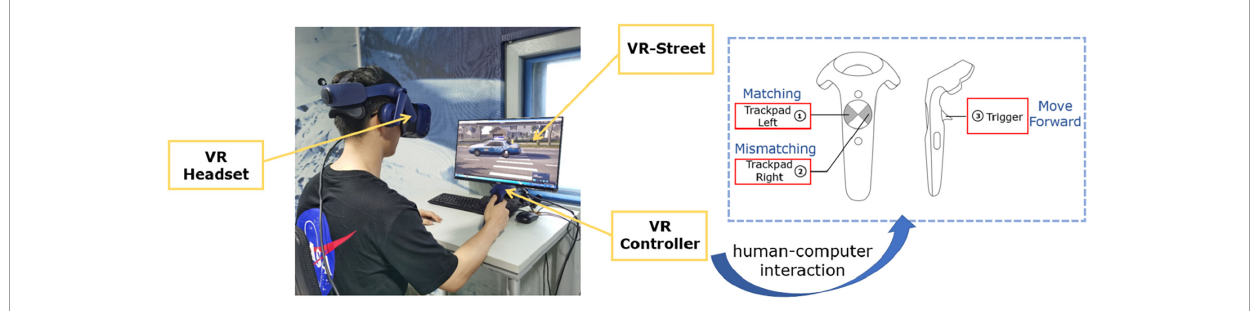
FIGURE4 The experimental diagram of the participants and the operation method of the handle.